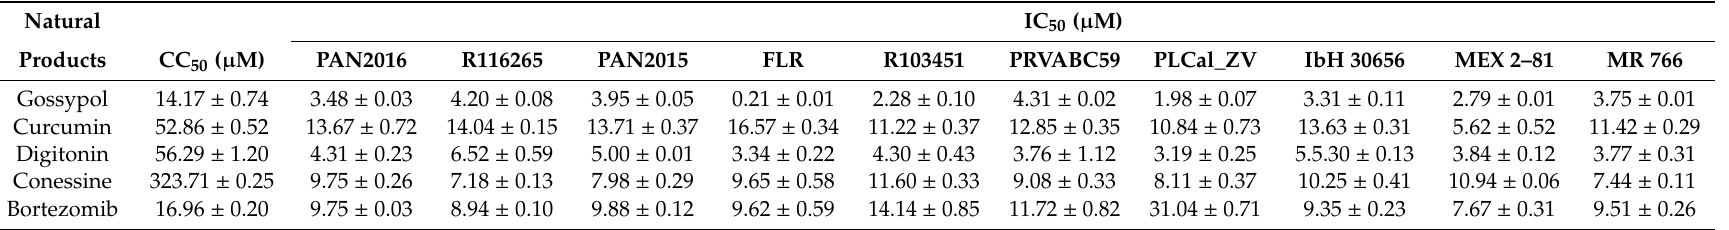
Table 2. Inhibitory activity of natural products against infections of ZIKV with di ff erent